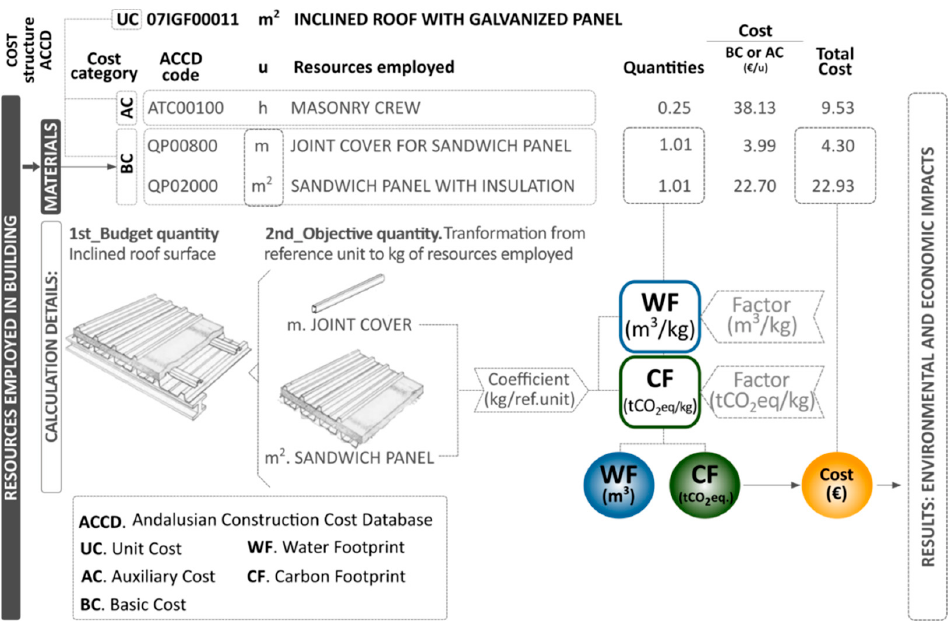
Figure 3. The industrial building unit is transformed into environmental impact per work unit.